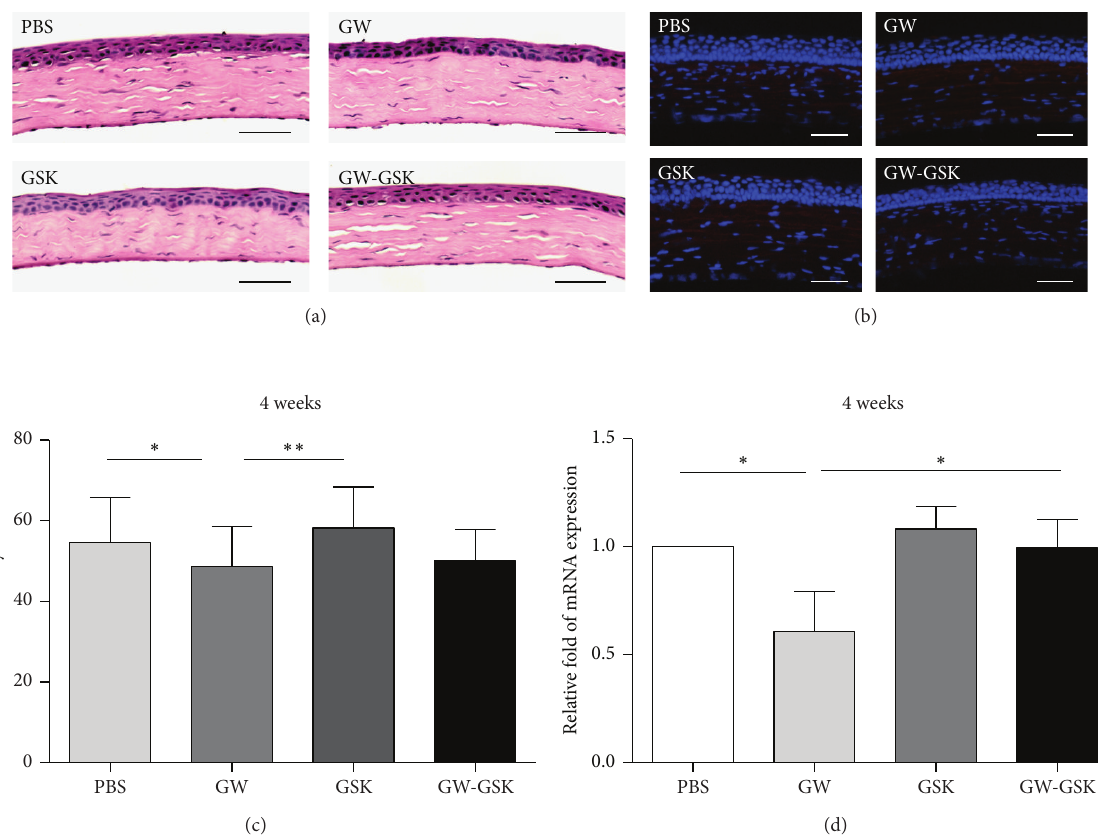
Figure 5: Effects of PPAR 𝛿 on keratocyte proliferation four weeks after surgery. (a) Representative images of H & E staining. Inflammatory or endothelial cells were not observed. Scale bars, 50 𝜇 m. (b) Representative immunofluorescent staining images for CD11b. No positive cells were observed. DAPI-stained nuclei are shown in blue, and CD11b is shown in red. Scale bars, 50 𝜇 m. Mean number of keratocytes (c) and mRNA expression of Ki67 antigen (d) are depicted in the bar graph. Data are presented as the mean ± SD ( 𝑛 = 3-4), and significant differences were statistically assessed using ANOVA. ∗ 𝑃 < 0.05 , ∗∗ 𝑃 < 0.01 versus GW501516